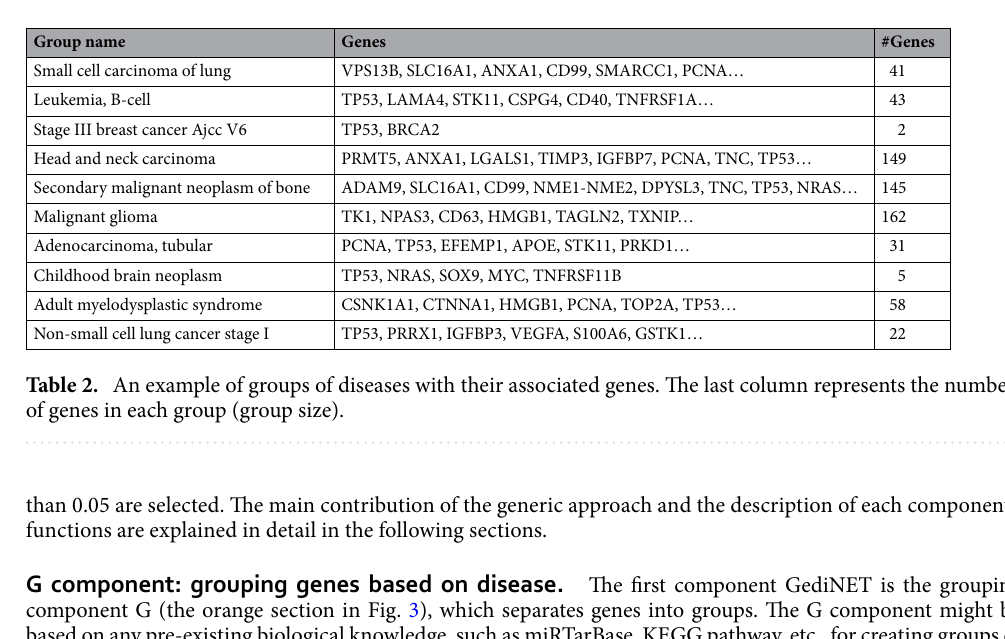
Figure 3. GediNET workflow. The main workflow of G-S-M that integrates pre-existing biological knowledge for grouping genes based on disease-gene association, which is derived from the DisGeNET v7 database.